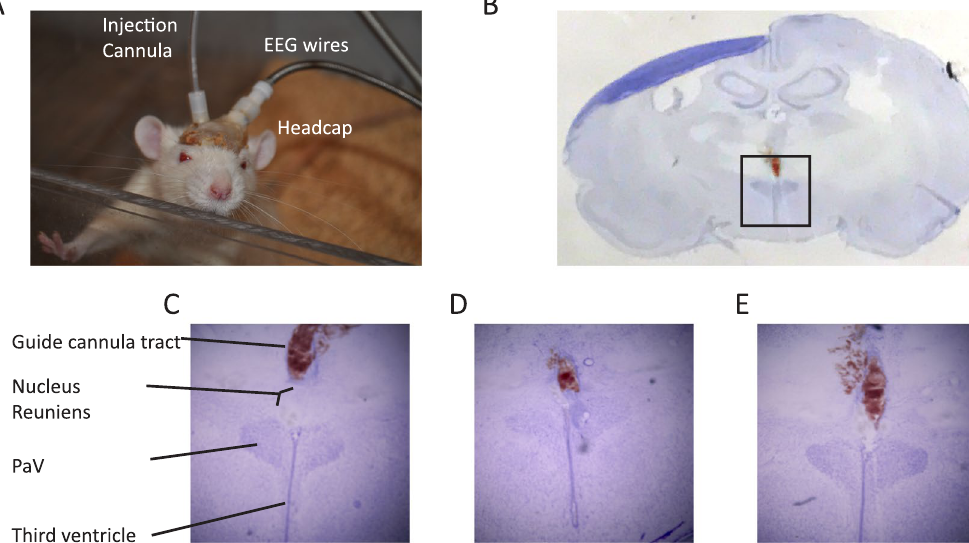
Figure 1. Verification of deep electrode and injection sites. ( A) Photograph showing location of guide cannula (here with injection cannula inserted) and EEG headcap. ( B) Low magnification Nissl stain with fluorescent DiI, showing relative location of the reuniens . The defining landmark is the dark, winged shape of the paraventricular hypothalamic nucleus (PaV), sitting astride the third ventricle. The nucleus reuniens is a loosely grouped nucleus just above the ventricle. Box: area shown in ( E ). Red stain is fluorescent DiI showing location of cannula. ( C–E) Three rats show successful targeting of the reuniens , here marked by DiI fluorescent staining ending just